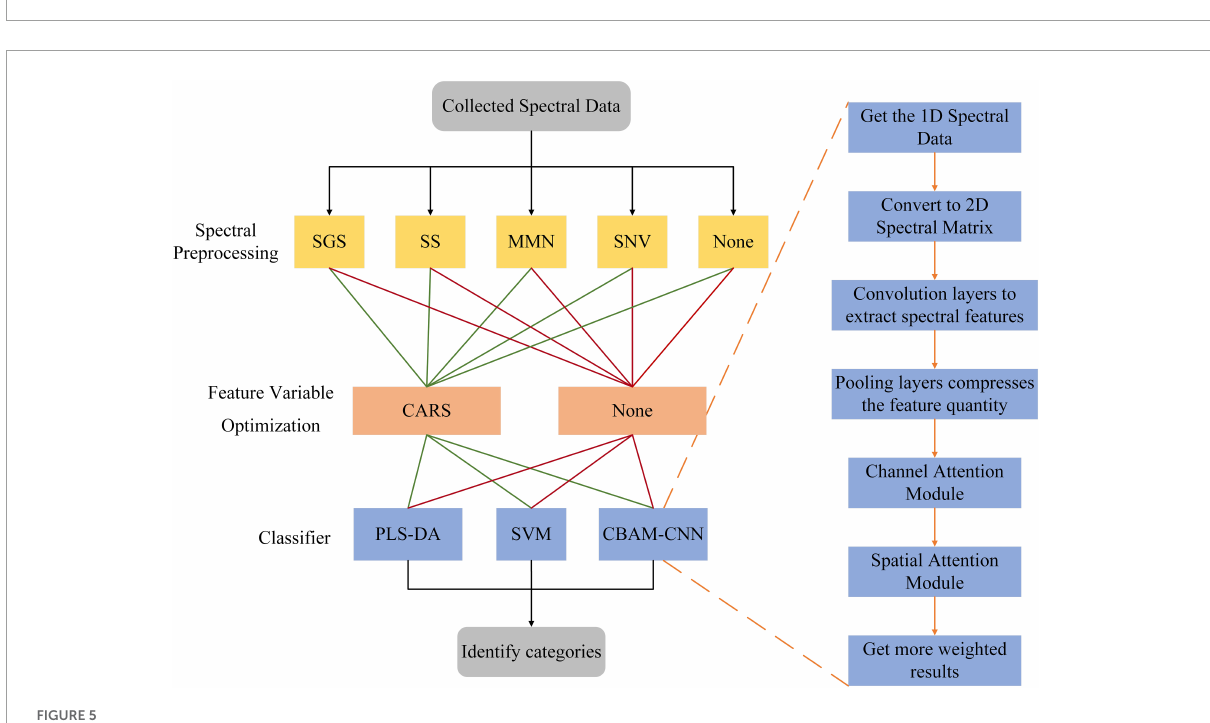
FIGURE5 Research method